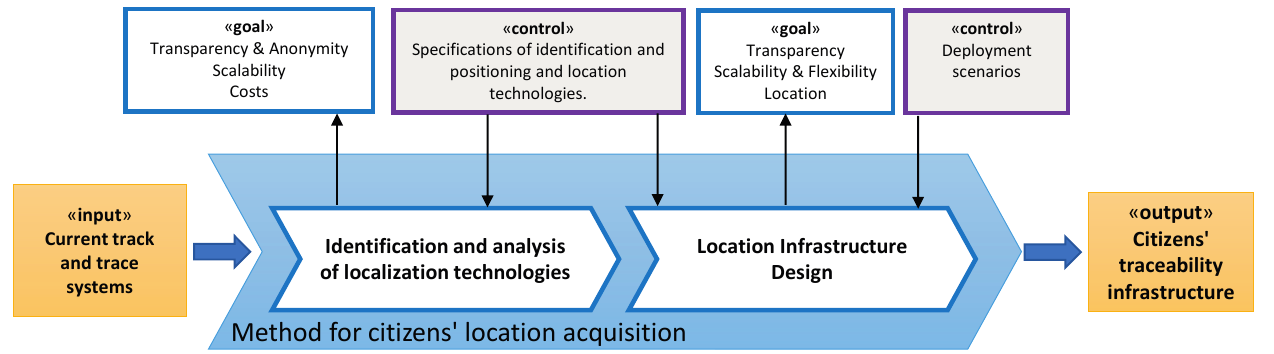
Figure 3. Modelling with Eriksson-Penker notation of Design of the method for citizens’ localization acquisition